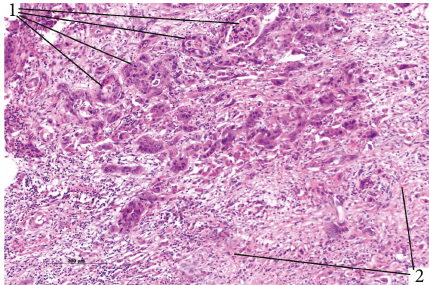
Figure 1: Cholangiocellular tumour with a forming coarse stroma in the setting of superinvasive opisthorchiasis (SO) was visualized with haematoxylin and eosin (HE) staining, magni fi cation 200x (1: tumour glandular complexes; 2: forming coarse stroma).